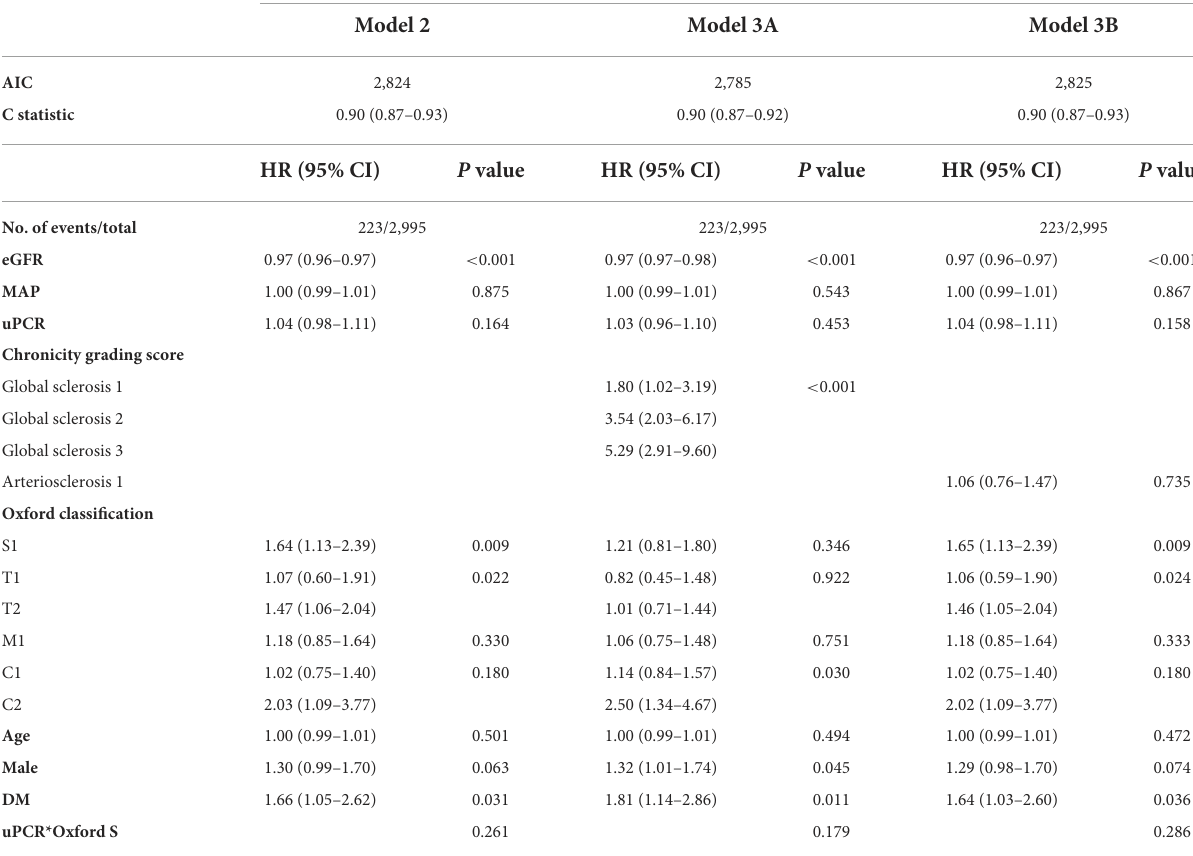
TABLE 8 Impact of global sclerosis in addition to Oxford classification on ESRD